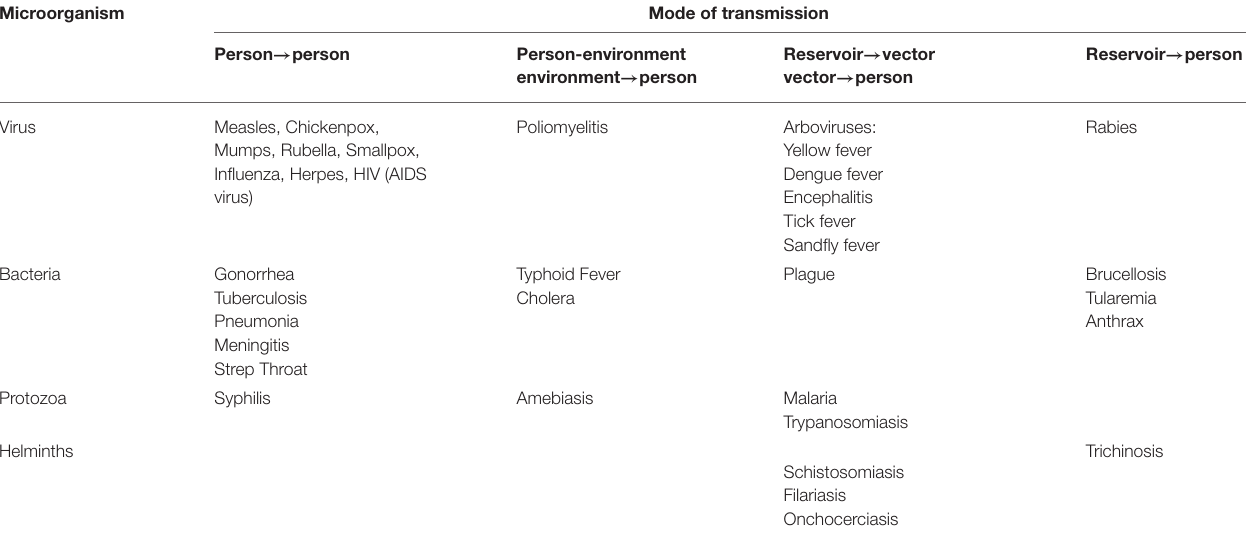
TABLE 4 | Different infectious diseases their causative microorganisms and modes of transmission.